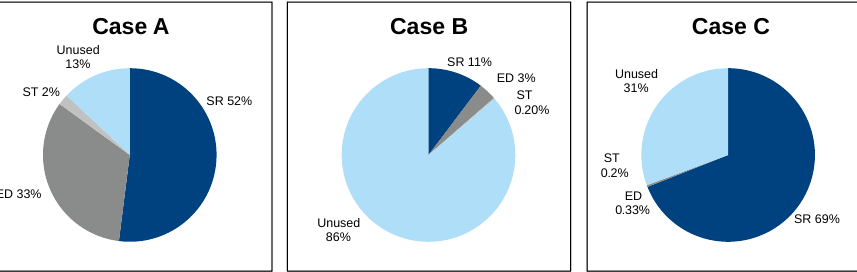
Figure 4. Workload vs. bandwidth in the three